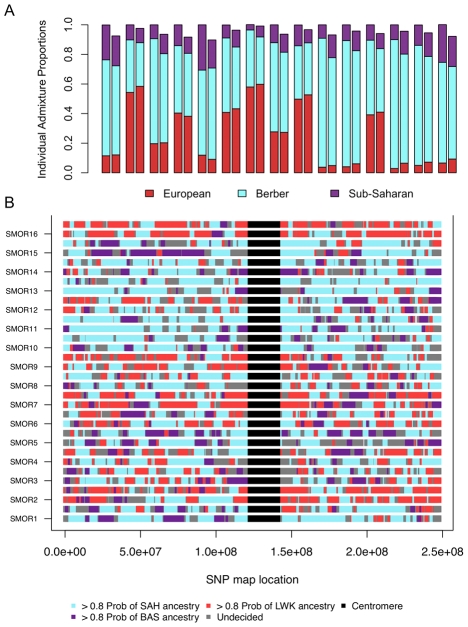
Correlation between ancestry proportions inferred from ADMIXTURE and PCADMIX.We compare the proportions of ancestry inferred from assuming 3 ancestral populations in individuals from South Morocco A) using a clustering algorithm set to k = 8 (Figure 1) summing the sub-Saharan ancestry, both Qatar and European ancestry, and Maghrebi ancestry. We compared these estimates (left bar) to our PCA-based local ancestry assignment estimates (right bar). The three ancestral populations were Saharawi [SAH], Bantu-speaking Luhya [LWK], and Spanish Basque [BAS]. B) Genome admixture deconvolution on chromosome 1 of sixteen South Moroccans. Using a principal component-based method of admixture deconvolution, we assign local ancestry to South Moroccan individuals. We implement our PCA-based method for k = 3, and choose the ancestral populations based on the three ancestral populations were Saharawi [SAH], Bantu-speaking Luhya [LWK], and Spanish Basque [BAS]. Chromosome 1 for all sixteen South Moroccans is presented for both the maternal and paternal haplotypes.